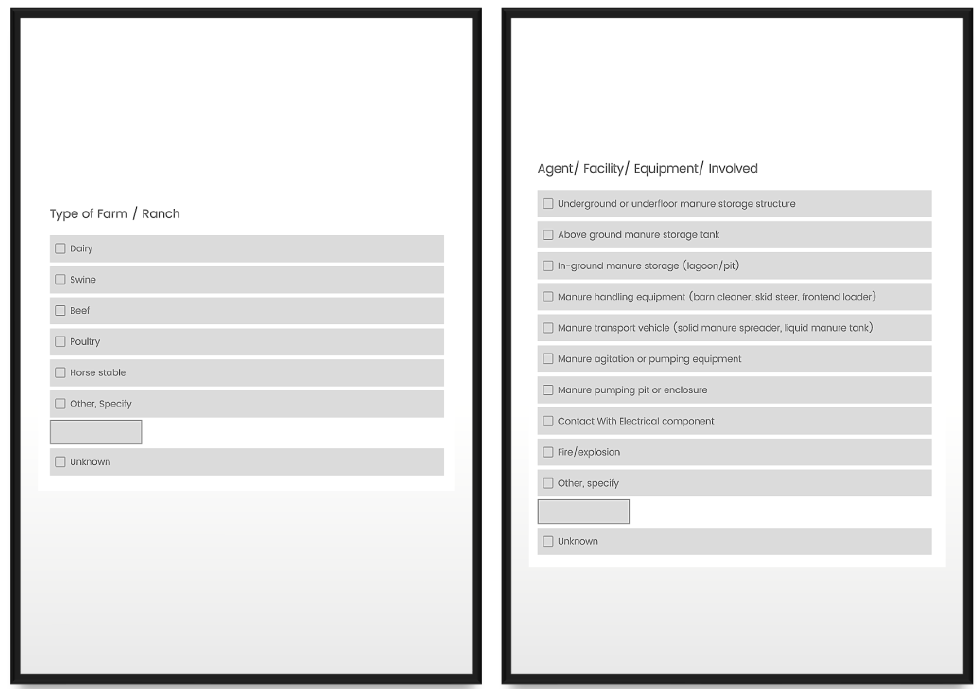
Figure 4. Qualtrics Survey Form: Farm Type and Agent involved.